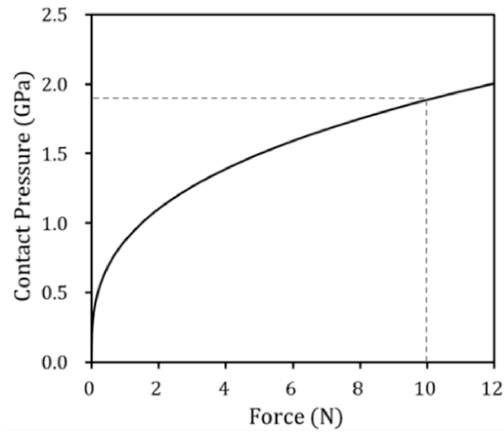
Figure 6. A normal force vs. contact pressure curve by the Hertz contact theory. The mechanical press is generally used for the sheet metal forming process of the B-pillar. The conventional stamping speed is approximately 10 spm in the B-pillar mass production process, and the maximum forming velocity is approximately 180 mm/s, considering the sliding motion of the sheet metal. Therefore, the maximum sliding velocity was set to 188.4 mm/s (120 rpm), with a rotation radius of 15 mm. The sliding distance was selected as 1000 revolution (94.20 m) for sufficient tool wear to occur. Table 3 shows the levels of the three contact parameters based on the above maximum test values. From these values, an orthogonal array L 25 (5 3 ) can be constructed as shown in Table